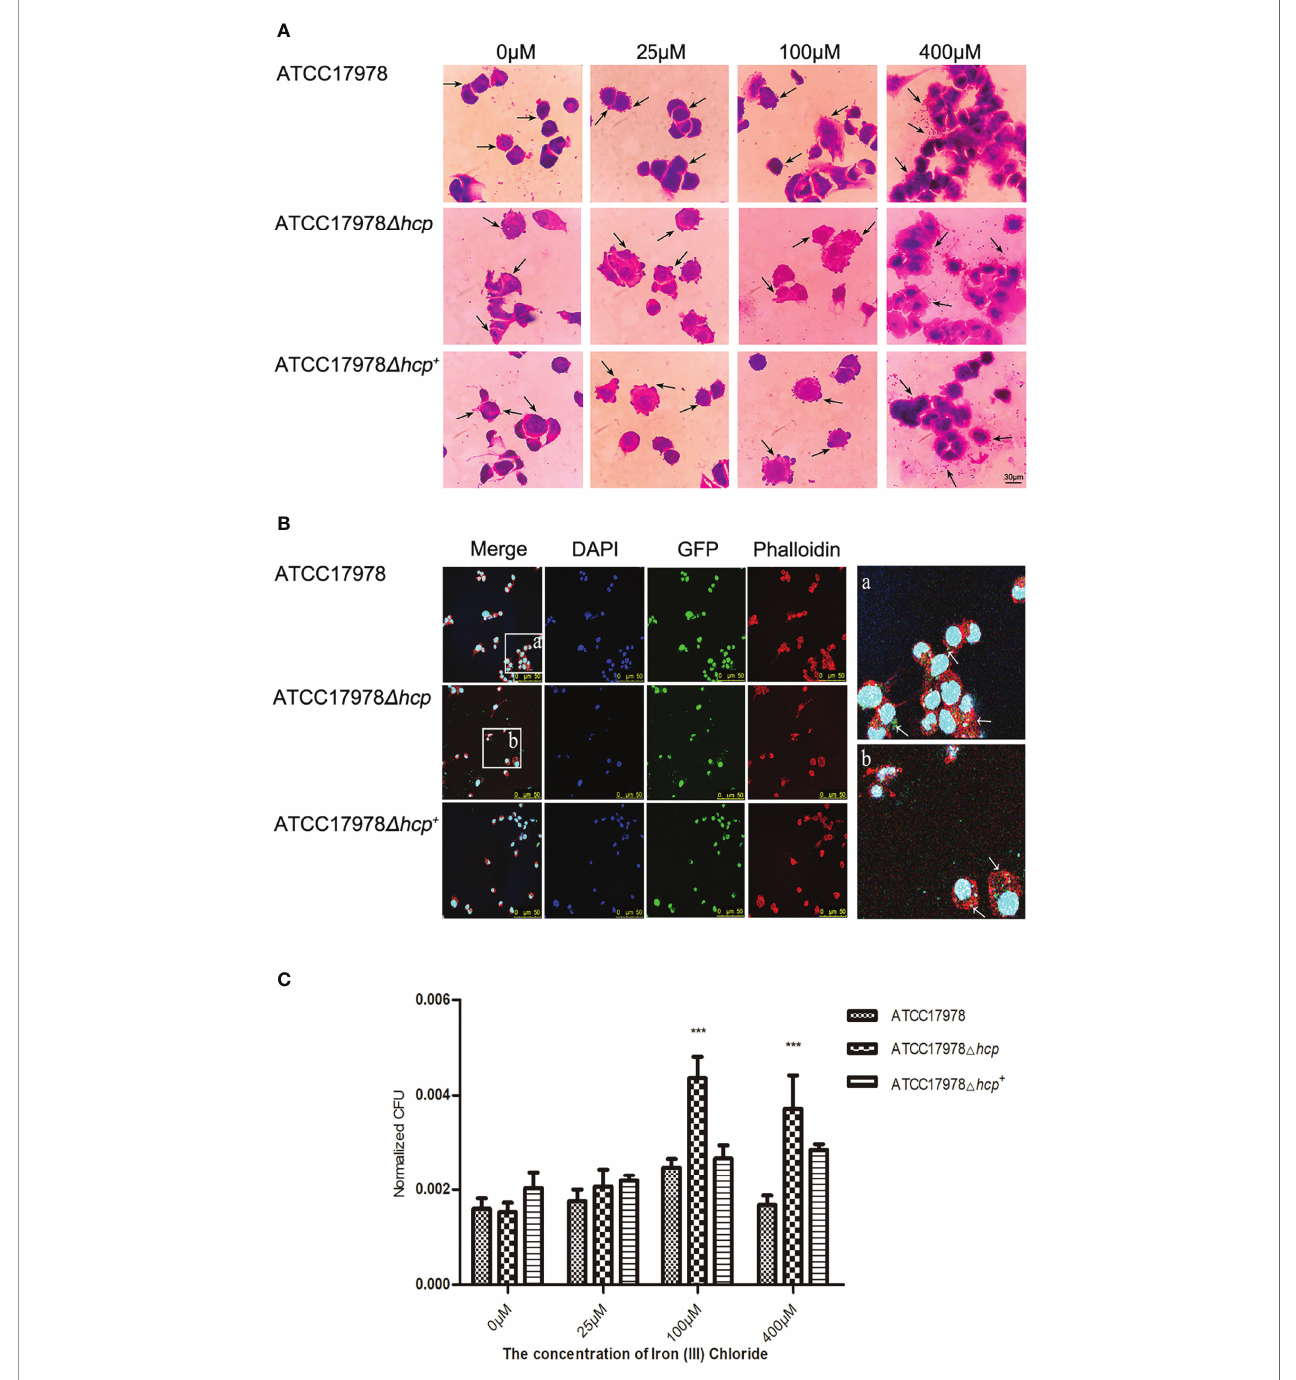
FIGURE 3 | Effect of iron on the Acinetobacter baumannii adhesion and invasion of human pulmonary alveolar epithelial cells (HPAEpiC). (A) Bacterial adhesion and invasion of the cells by the three strains (ATCC17978, ATCC17978 D hcp , and ATCC17978 D hcp + ) in the presence of different concentrations of iron ions was observed under a conventional microscope. The arrows point to bacteria attached to the cell surface (not all marked, ×1,000). Scale bar = 30 m M. (B) Fluorescence microscopy of the effect of hcp on bacterial adhesion and invasion of the cells. The blue fl uorescence represents cellular nucleic acids that were stained with DAPI; green fl uorescent protein (GFP) was the fl uorescent marker of bacteria, and the red fl uorescence corresponds to a phalloidin staining of cellular actin, ×400. Schematic diagram of bacterial adhesion and invasion of HPAEpiC. The GFP labeling is indicated by arrows (not all marked). (C) The results of the bacteria count for bacteria adhesion and invasion of HPAEpiC by the three strains at different concentrations of ferric ion. *** represents means that are under the same iron ion. Compared with ATCC17978, ATCC17978 D hcp has a signi fi cant difference in normalized CFU adhesion and invasion of HPAEpiC ( p <